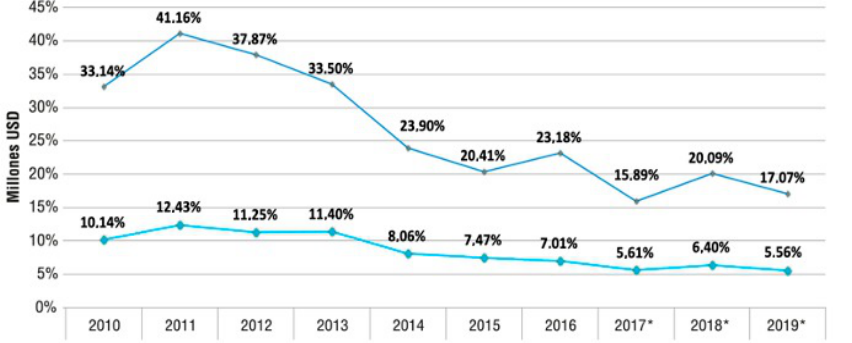
Figure 1. Percentage of public procurement of millons in relation to the General State Budget (public procurement portal